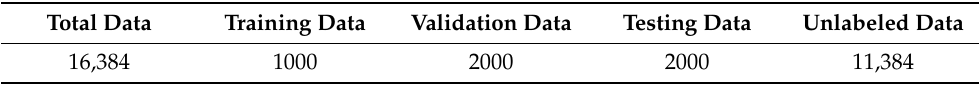
Table 8. Training/validation/testing/unlabeled separation statistics (DNN, mHealth).